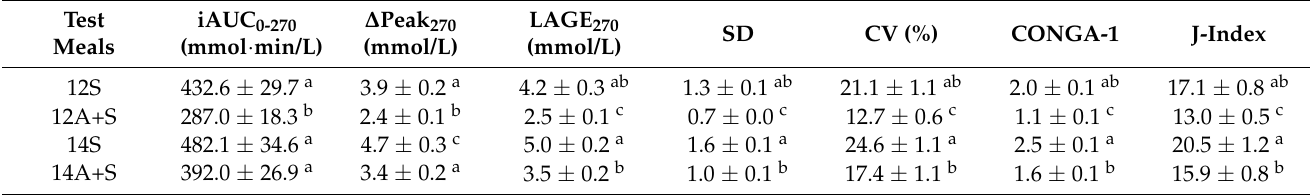
Figure 2. Postprandial interstitial glycemic responses following the lunch test meals. 12S, standard- ized lunch at 12:00; 12A+S, apple preload 30 min prior to 12S; 14S, standardized lunch at 14:00; 14A+S, apple preload 30 min prior to 14S. − 30 min = the commencement of the water or apple; 0 min = the time when the standardized mixed meal was given. Data are mean ± SE ( n = 26). * Apple preload treatments (A+S) different from their standardized lunch (S) counterparts ( p < 0.05), ‡ 14S different from 12S ( p < 0.05). Table 3. Postprandial interstitial glycemic parameters for the lunch test meals (mean ± SE, n =